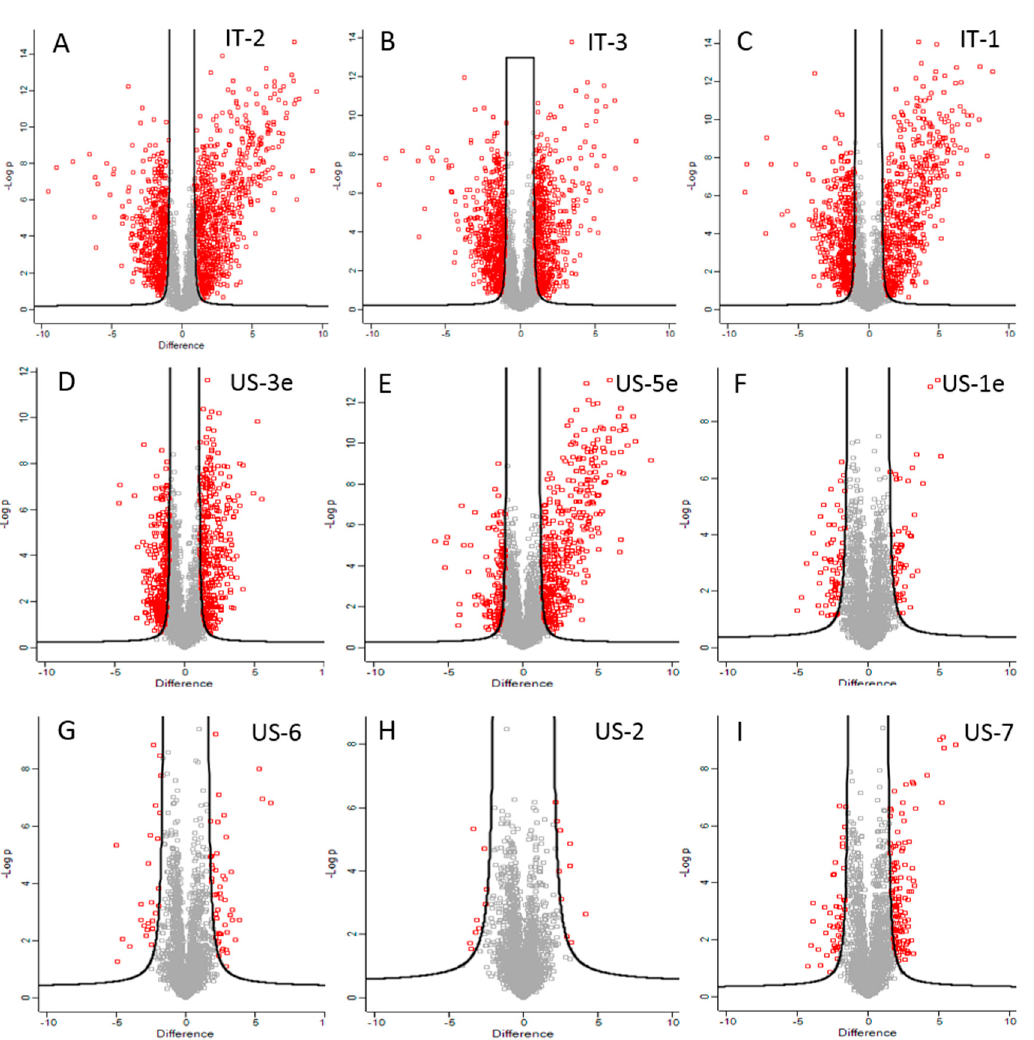
Figure 1. Perseus volcano plots representing proteins with differential abundance (red squares) between the tested VSL#3 samples and US-4. For each protein, significance expressed as p -value was graphed in function of difference between samples (log2 fold change). Red squares in the right area of each volcano plot represented proteins significantly more abundant in IT- and US-products while red squares in the left side of plots corresponded to proteins more abundant in the US-4 product.